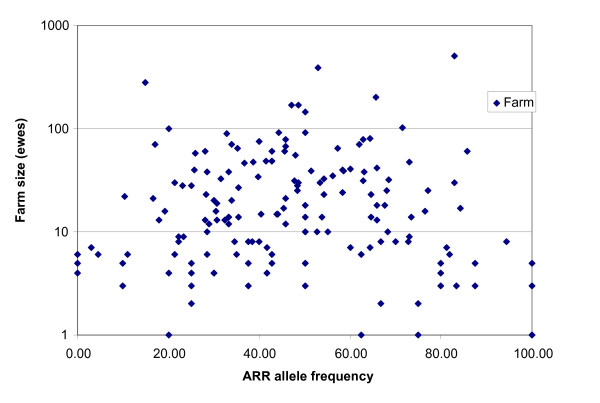
Farm level PrP frequency variation. Scatterplot of the farm size, measured by the number of ewes against ARR allele frequency measured on the farm (n = 168).